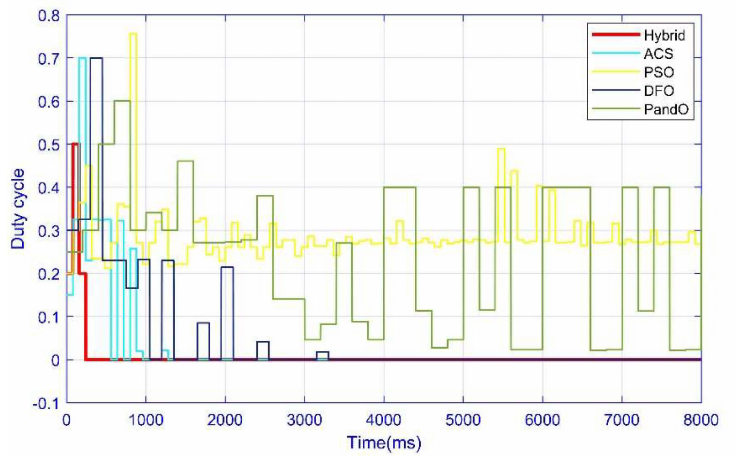
Figure 16. Case 4: Duty cycle comparison of hybrid with other